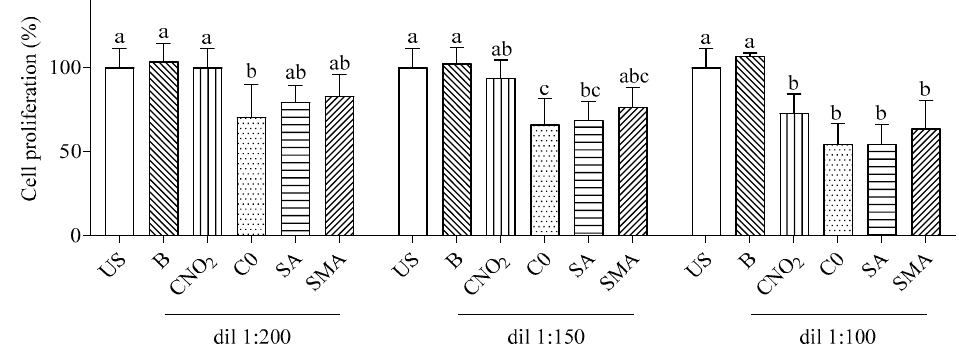
Figure 3. Antiproliferative effect of digested salami formulations. Data are means ± SD of three independent supplementation of in vitro digested, each one analyzed in triplicate. The antiprolifera- tive effect is expressed as the percentage of cell numbers representing unsupplemented (US) cells (assigned 100%). Statistical analysis was by one-way ANOVA (always p < 0.05) with Tukey’s post-hoc test comparing US and supplemented cells for each dilution (different letters indicate significant differences). B: “blank” digestion; dil: dilution; C-NO 2 : salami with sodium nitrite, potassium nitrate and with nitrate-reducing microbial starter cultures; C-0: salami containing neither nitrate- reducing microbial starter cultures nor additives (nitrite, polyphenols and ascorbate); SA: salami with nitrate-reducing microbial starter cultures and sodium ascorbate; SMA: salami with nitrate-reducing microbial starter cultures, sodium ascorbate and plant